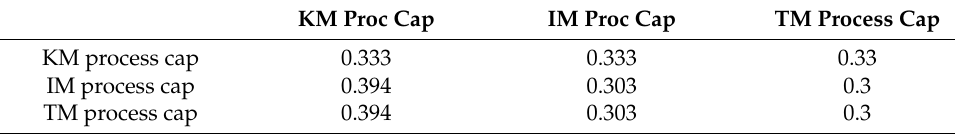
Table 9. Normalized relation matrix T α (Dimension)